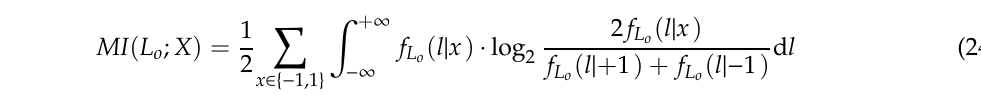
Figure 4. Discrete-time channel response used in simulation analysis.